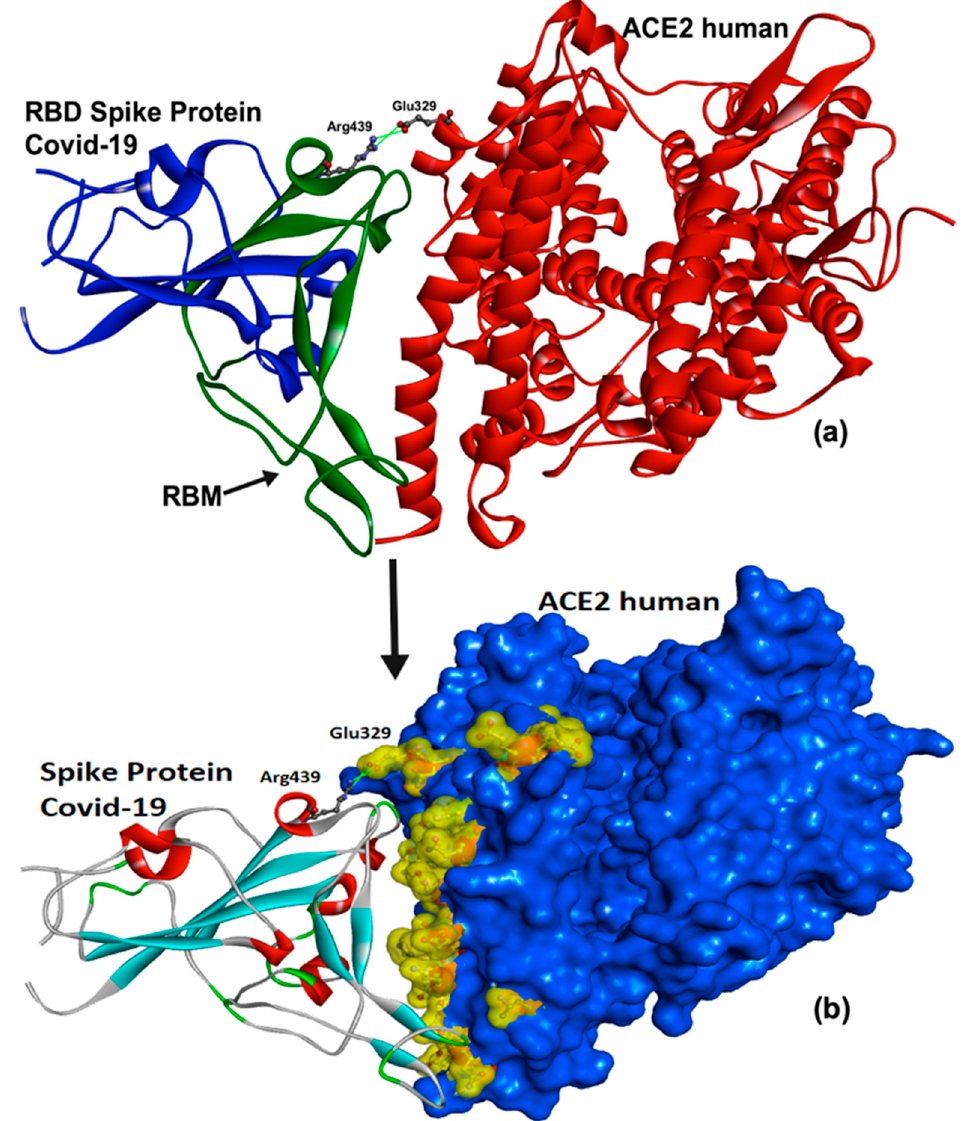
Figure 4. ( a ) Structure of the receptor-binding domain (RBD) of the S protein in SARS-CoV-2 (blue and green ribbons) complexed with human ACE2. The green ribbon denotes the receptor-binding motif (RBM) within amino-acid residues 424–494 or 438–504 [62,64]. ( b ) The active site of ACE2 (yellow color) that directly interacts with the RBD of the S protein of SARS-CoV-2. The interaction between the S protein of SARS-CoV-2 and hACE2 is stabilized by a hydrogen bond (green lines) between Arg439 (S protein SARS-CoV-2) and Glu329 (hACE2). The figure was created using Discovery Studio Biovia through visualization of the Protein Data Bank (PDB) structure 6VW1 [65].